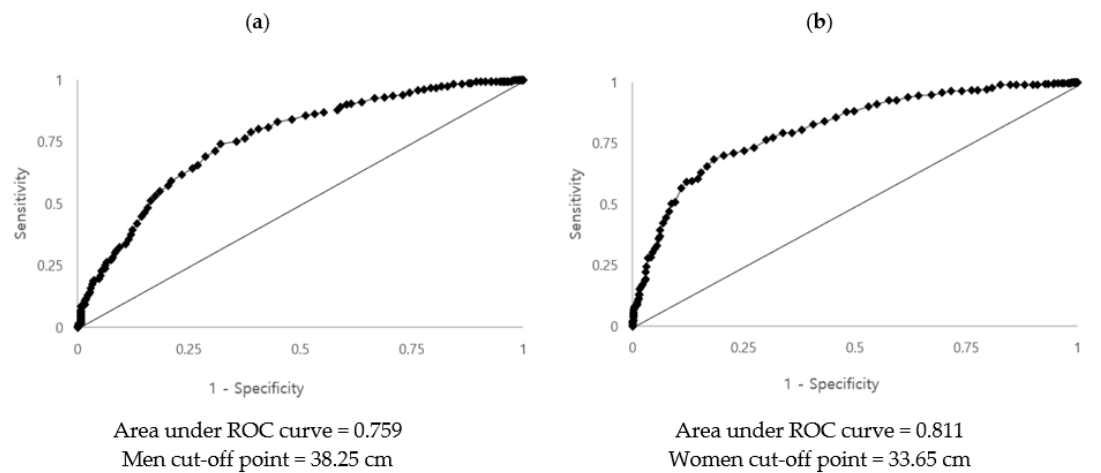
Figure 1. Receiver operating characteristic curve of neck circumference for predicting MetS in men ( a ) and women ( b ).